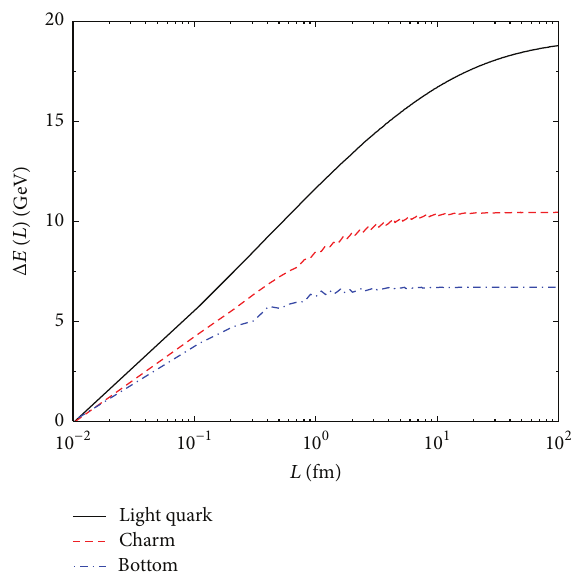
Figure 27: Variation of energy loss, Δ𝐸 as a function of path traversed, 𝐿 in vacuum. The energy of the quark is taken as 𝐸 = 20